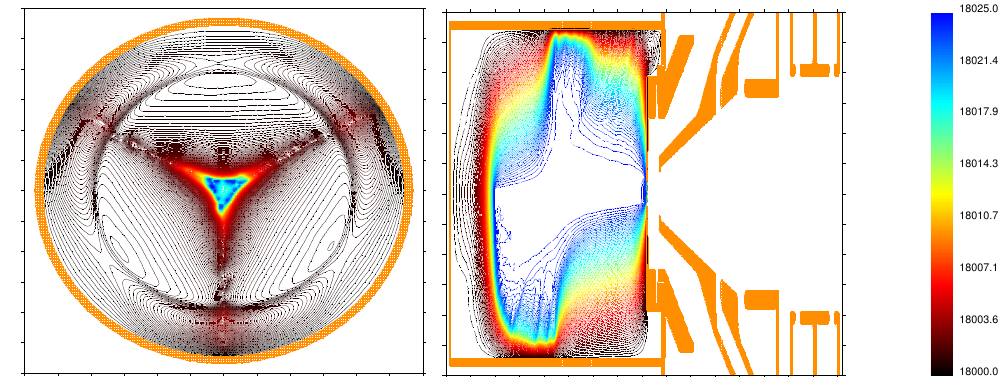
Figure 10. Potential distribution within the plasma chamber. Only three “active” loss lines are used to describe the plasma. Lines of constant potential from extraction electrode potential to plasma potential are shown. Left: cut in the beam direction just in front of the extraction aperture. The distorted azimuthal potential distribution is caused by space-charge. Right: cut in the transverse direction (perpendicular to beam